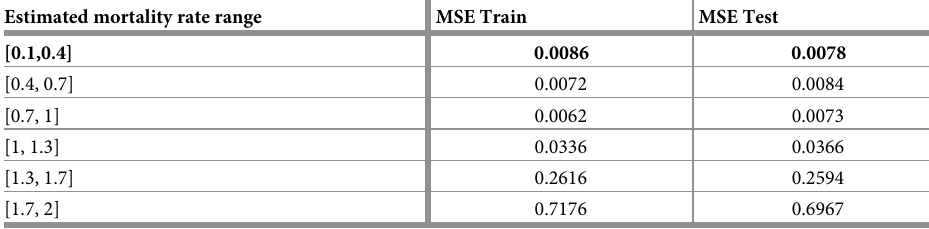
Table 10. Total mean square error (MSE) of training and testing data in the best implementation of the ANN-PSO network for estimating the mortality rate of COVID-19 patients in the ranges of [0.1,0.4], [0.4,0.7], [0.7, 1], [1.1.3], [1.3,1.7] and [1.7,2]. Estimated mortality rate range